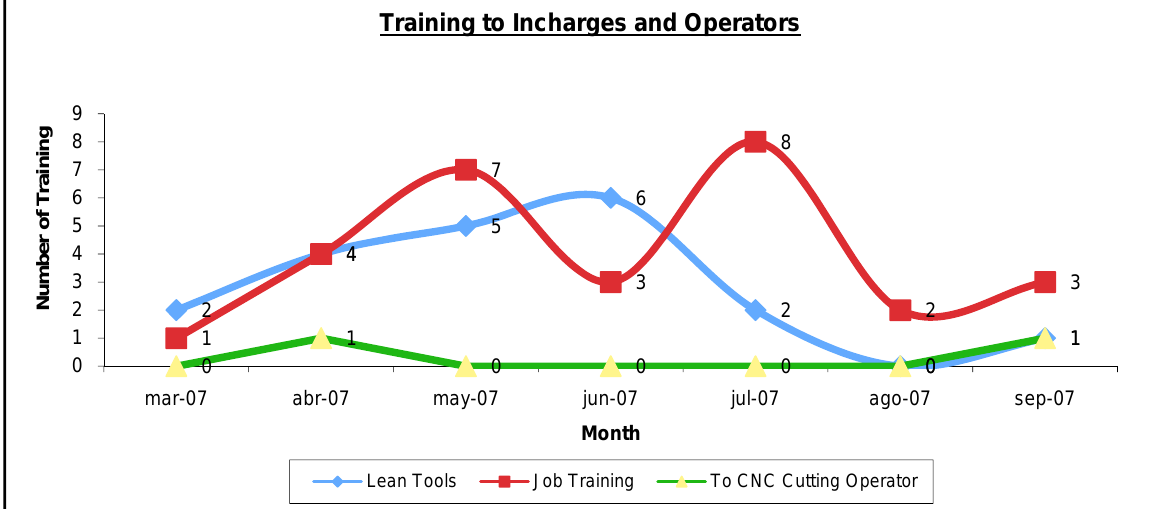
Figure 4. “Types of training to in-charges and